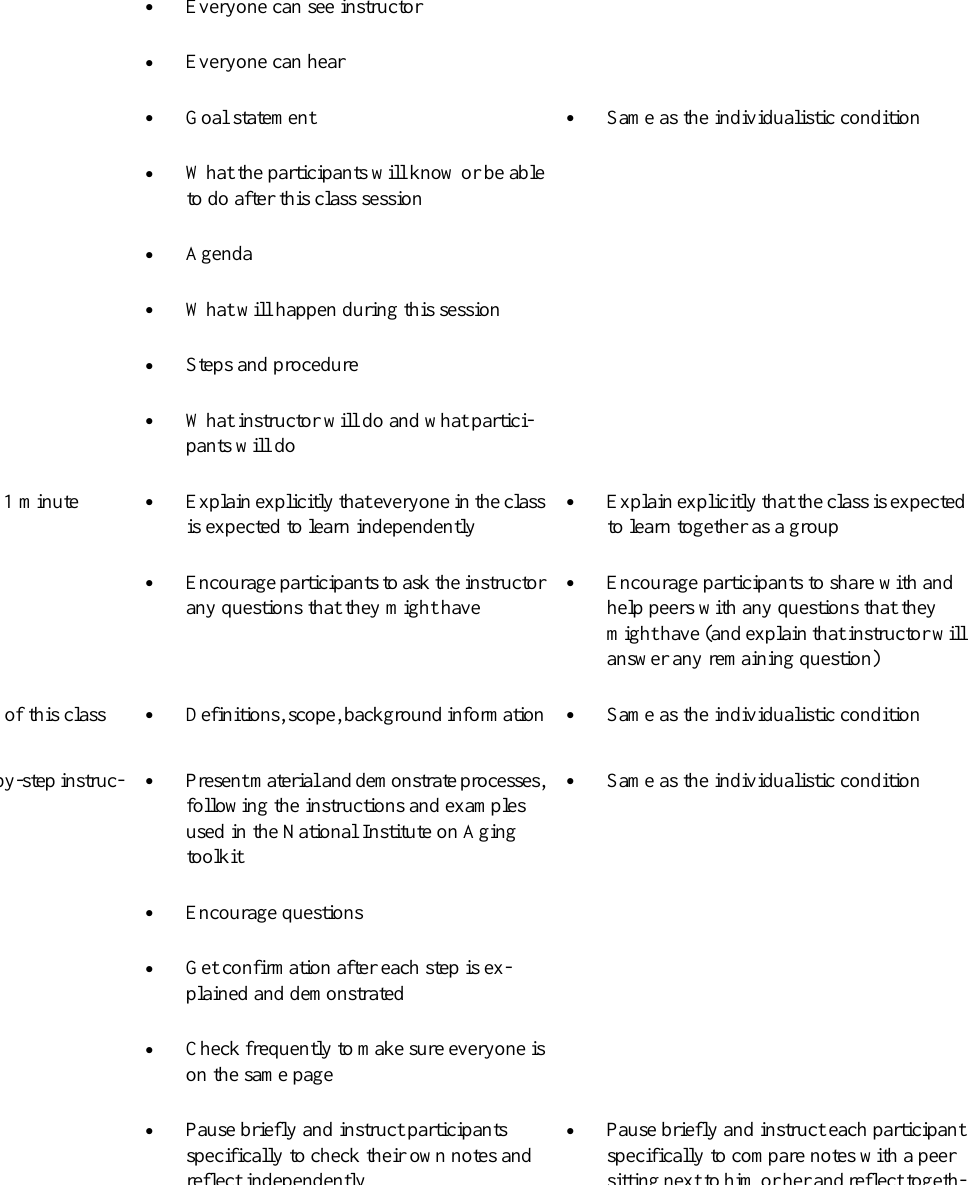
Collaborative learningIndividualistic